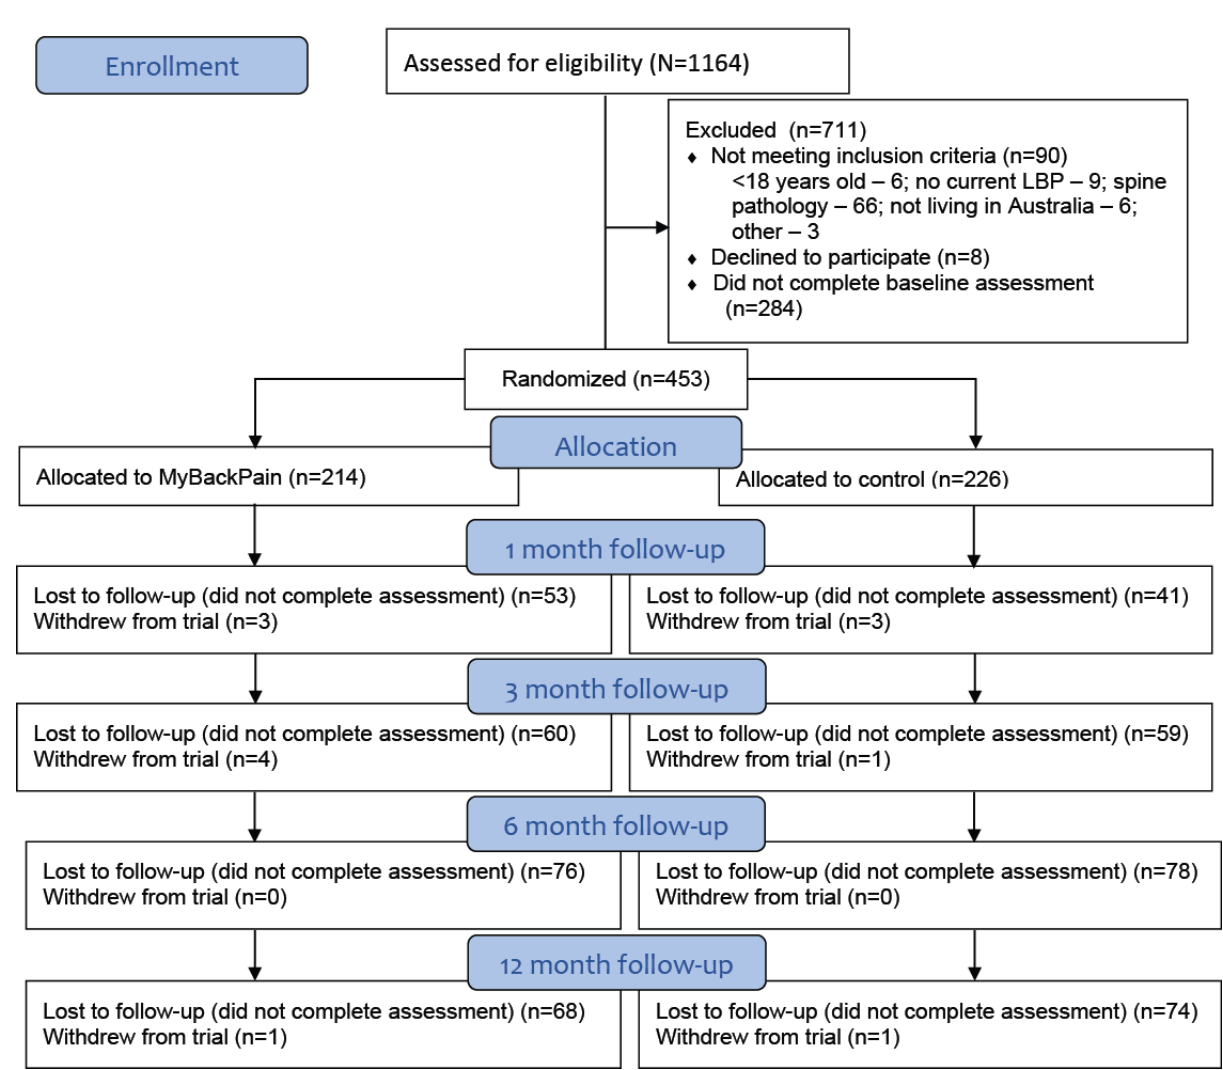
Figure 1. CONSORT (Consolidated Standards of Reporting Trails) flow diagram. LBP: low back